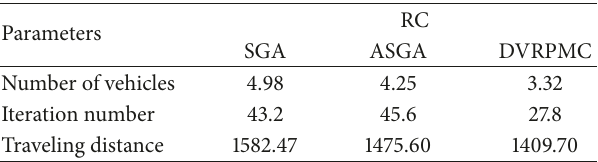
Table 3: Comparison of the calculation results of various algo-